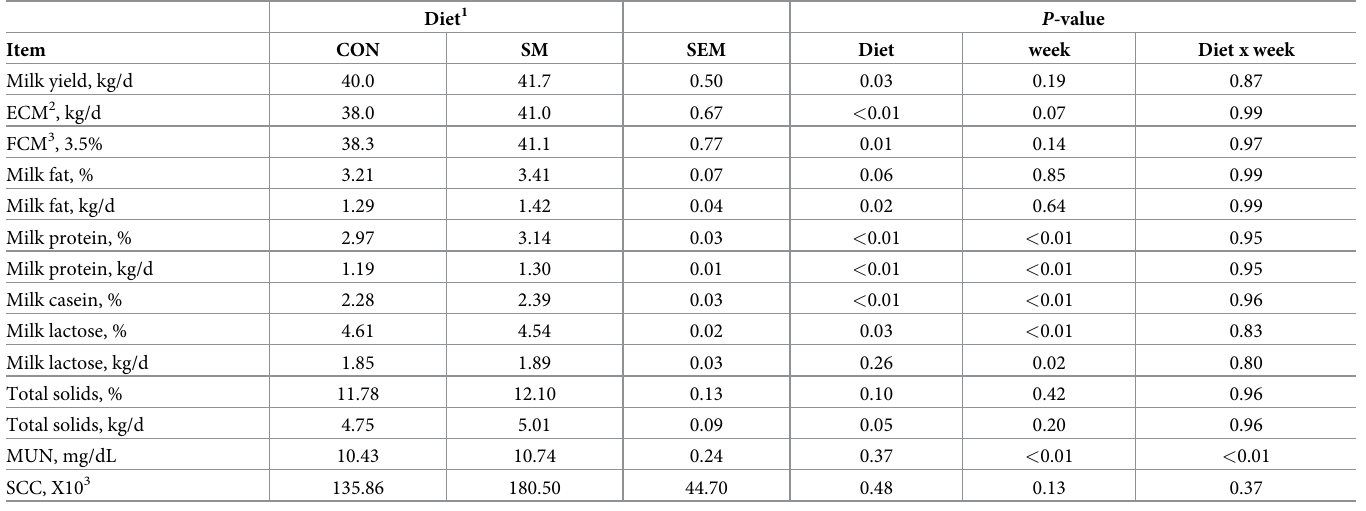
Table 3. Effects of the dietary treatments on milk yield and composition in dairy